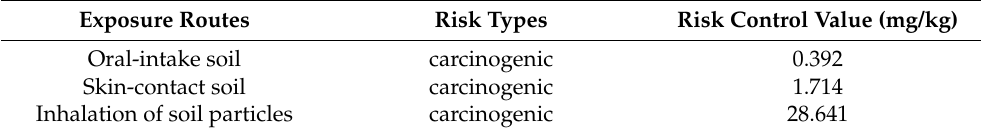
Table 9. Risk control value of Cd in the coalification zone